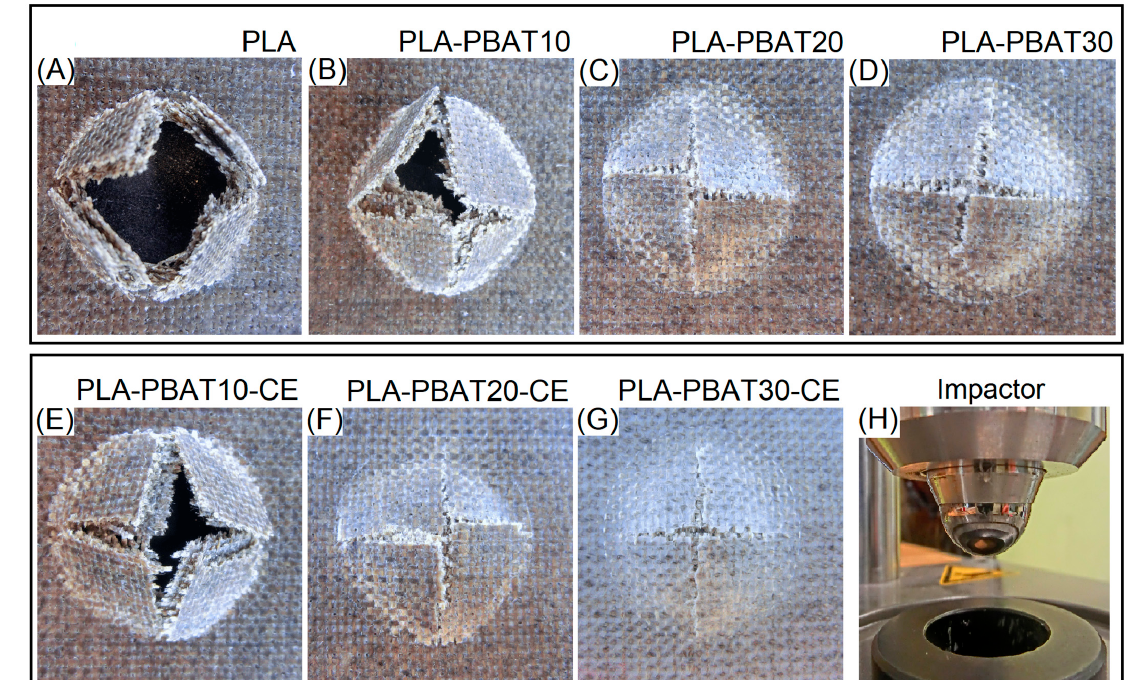
Figure 7. The results of the falling weight impact measurements for ( A ) pure PLA/FF laminate, ( B – D ) PLA-PBAT matrix samples, ( E – G ) PLA-PBAT-CE matrix composites, ( H ) the appearance of the apparatus impactor.